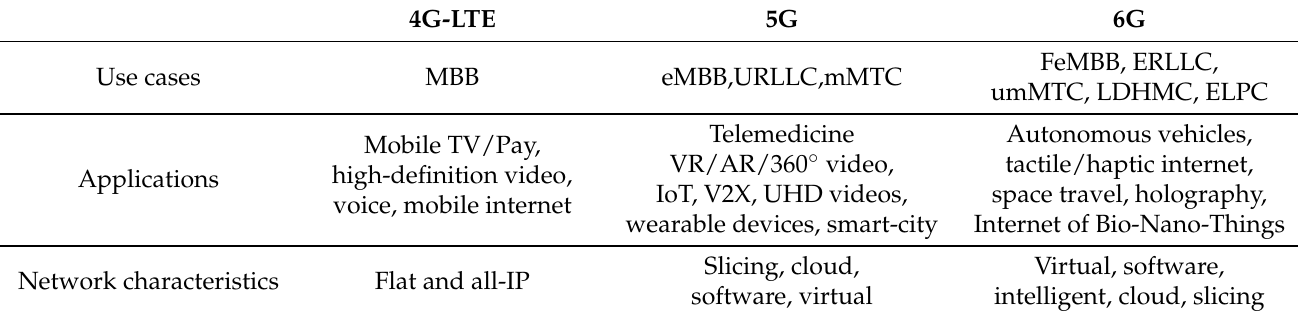
Figure 2. 5G wireless communication architecture. Table 4. 4G, 5G, and 6G characteristics, application, and use